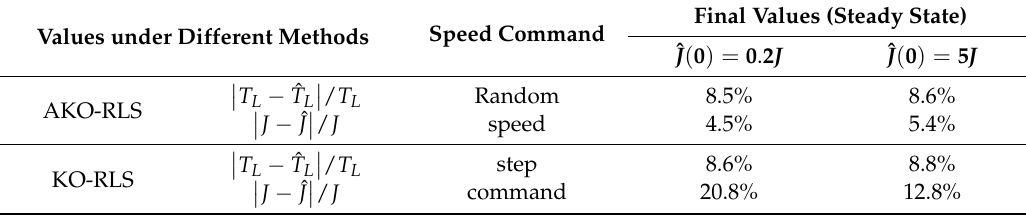
Table 5. Experiment Identification Results (under 1.2 Nm and random speed step